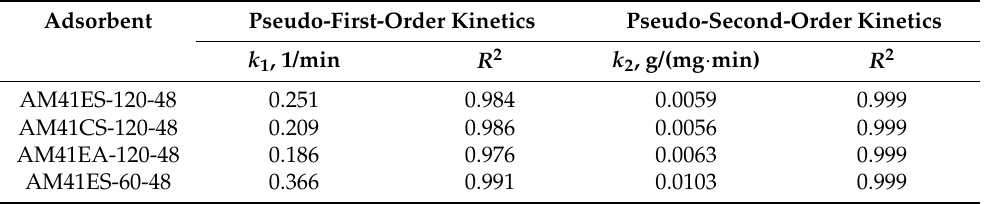
Table 9. Kinetic constants and R 2 of pseudo-first-order and pseudo-second-order models for